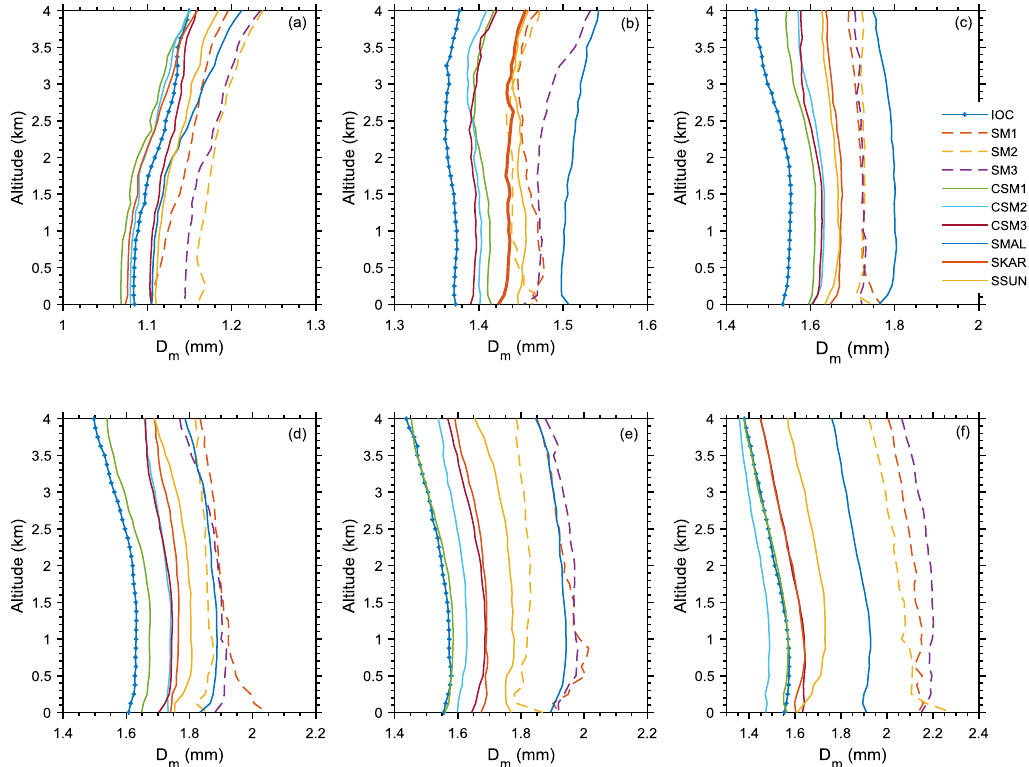
Figure 8. Vertical profile of mass-weight mean diameter ( D m ) for ten selected locations of convective rain for a) very light rain, b) light rain, c) moderate rain, d) heavy rain, e) very heavy rain, and f) extreme